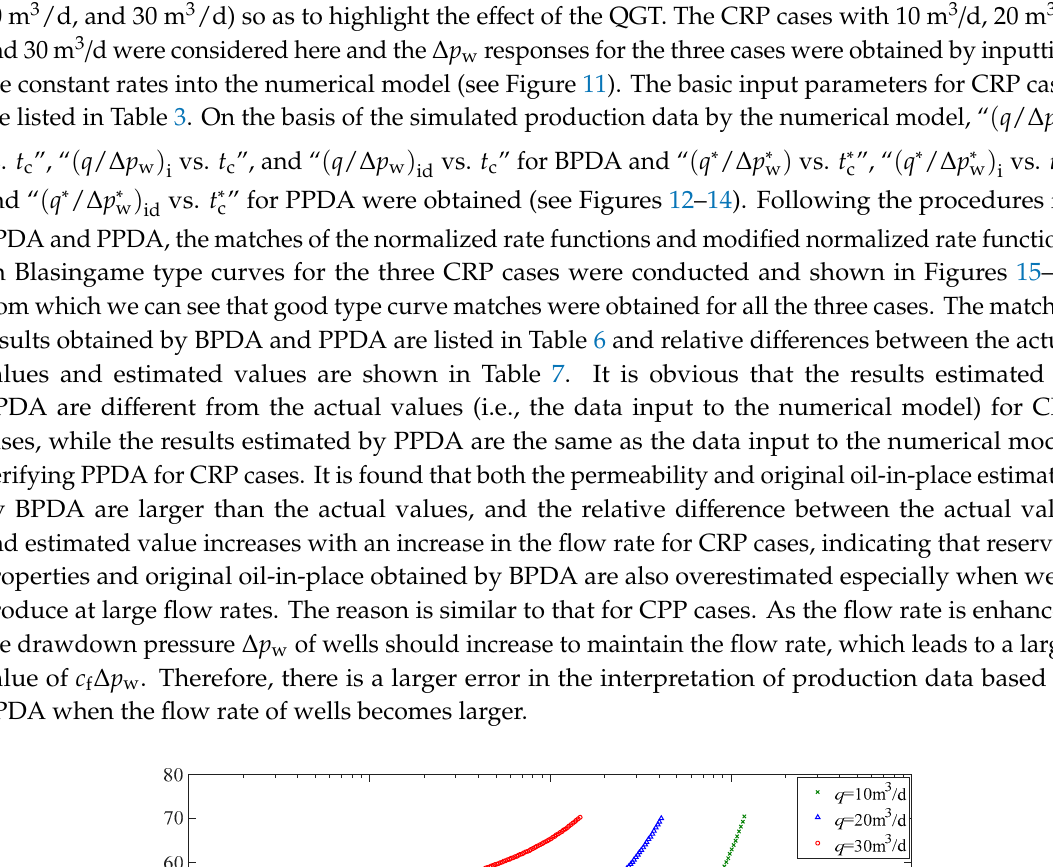
Figure 12. Normalized rate functions and modified normalized rate functions for CRP case of 3 10m d q = . Figure 13. Normalized rate functions and modified normalized rate functions for CRP case of 3 20 m d = q .